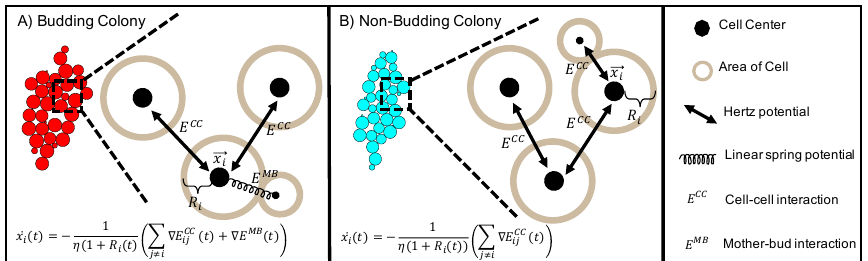
Figure 12. Biophysical Model of Cell-Cell Interactions. We simulate budding ( A ) and non-budding ( B ) colonies using a 2D center-based modeling approach where cells interact through different potentials. ( A ) For budding colonies, the mechanical interactions of all cell pairs ( E CC ) are governed by a combination of repulsive and attractive interactions using a modified Hertz-model described in Equation (1). We use a linear spring to model the additional adhesive force between mother cells and new daughter cells during the budding phase ( E MB ) as in Equation (4); ( B ) For non-budding colonies, the mechanical interactions are similar to that of cells in budding colonies except that the adhesive force between mother cells and new daughter cells during the budding phase ( E MB ) is neglected (see Section 4.1.1 for